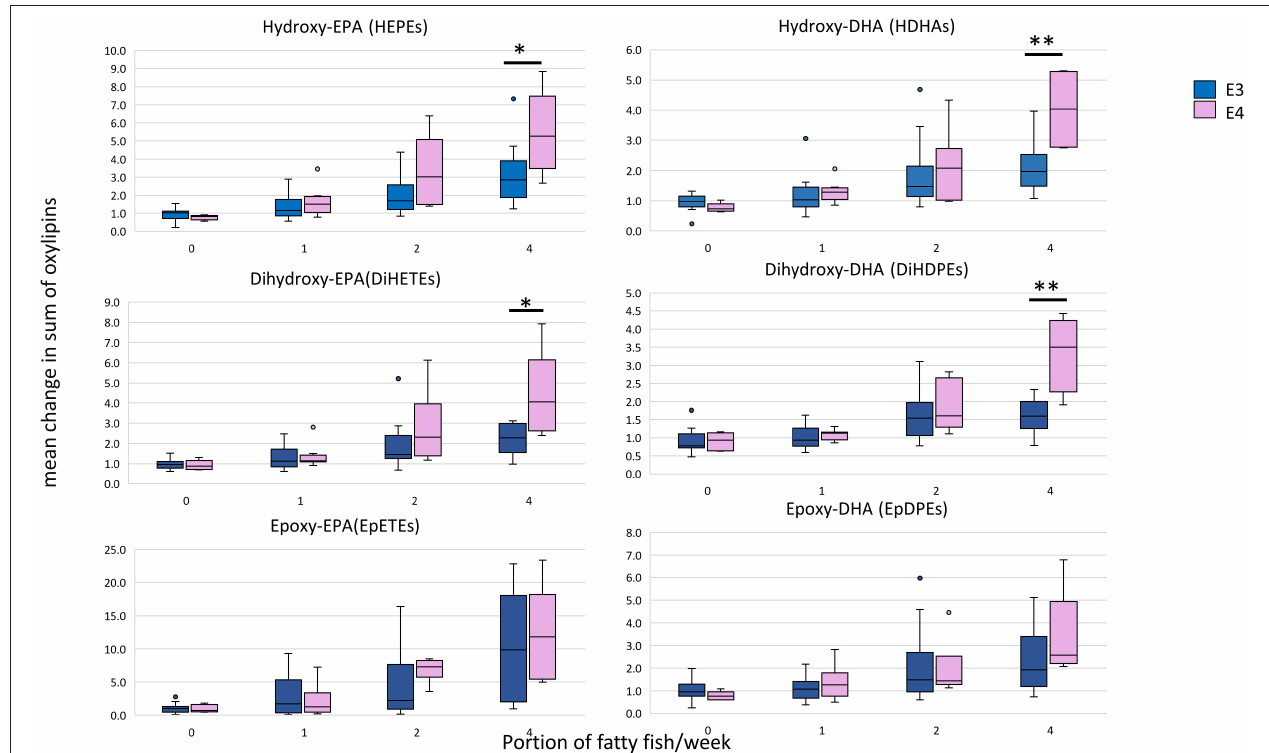
FIGURE 3 | Box plots showing the mean relative change in oxylipin levels at 12 months with EPA + DHA intake, stratified according to APOE genotype. The concentrations of all HEPEs, HDHAs, EpETEs, and EpDPEs covered by the analytical method were summed from the individual data, i.e., 9 × HEPEs, 10 × HDHAs, 4 × DiHETEs, 5 × DiHDPEs, 3 × EpETEs, and 4 × EpDPEs. Mann-Witney test was used to compare APOE genotypes within each dose. *Statistically significant, P < 0.05; **Statistically significant, P < 0.01. APOE3 n = 66, APOE4 n = 26.